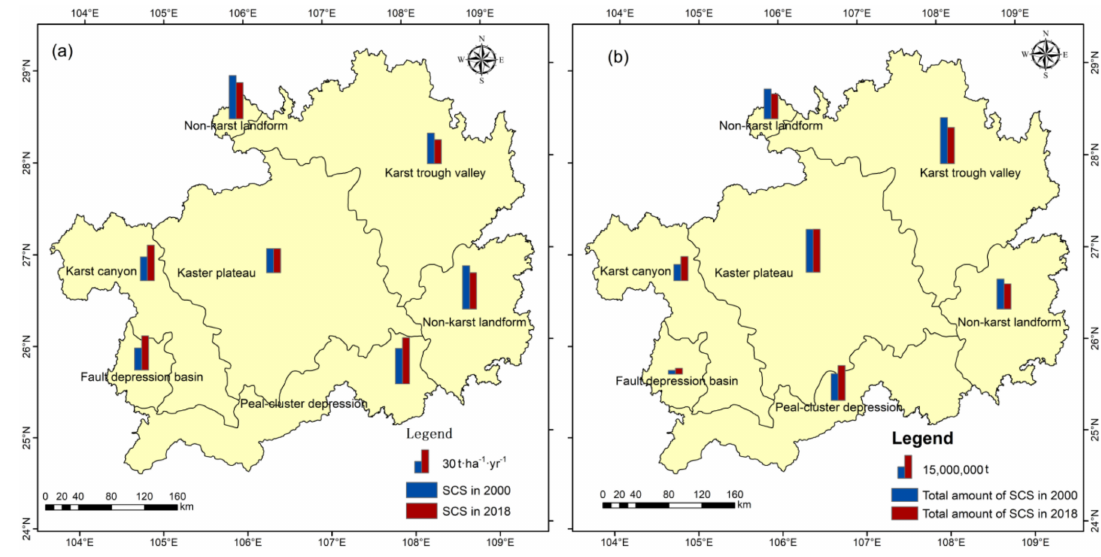
Figure 9. Distribution of SCS ( a ) and total amount of SCS ( b ) of 2000 and 2018 in di ff erent landform regions on the Guizhou